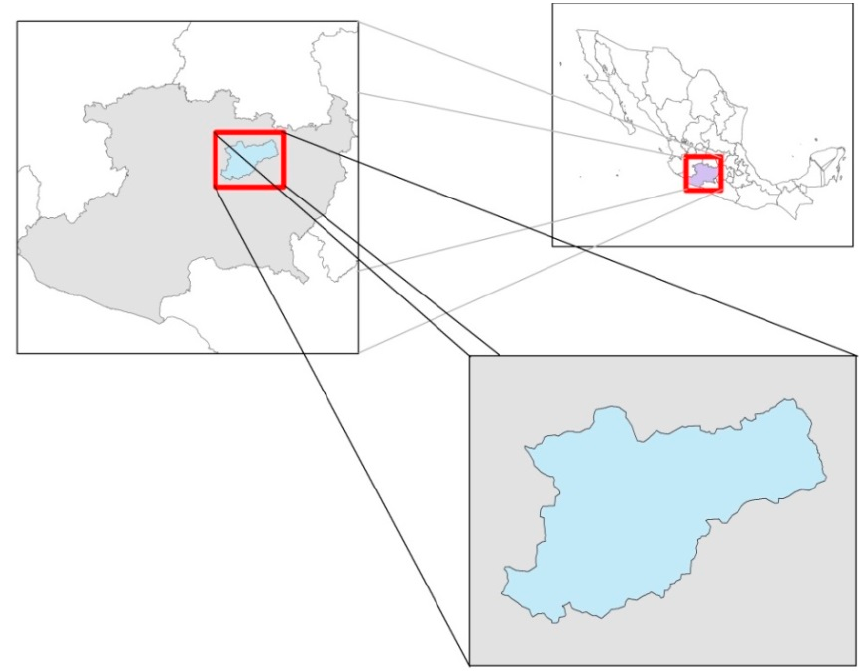
Figure 2. Location of the river basin of the Rio Grande of Morelia.